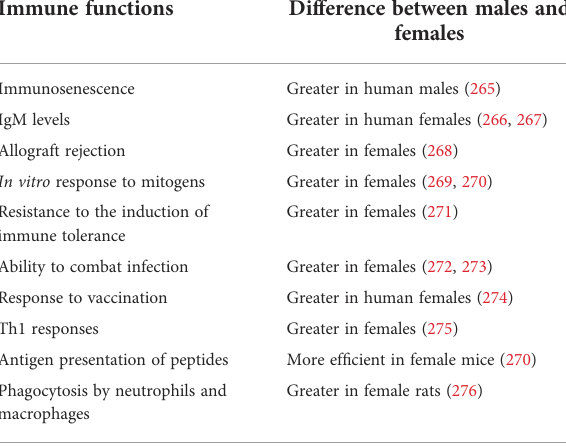
TABLE 7 Sexual dimorphism in immune processes.